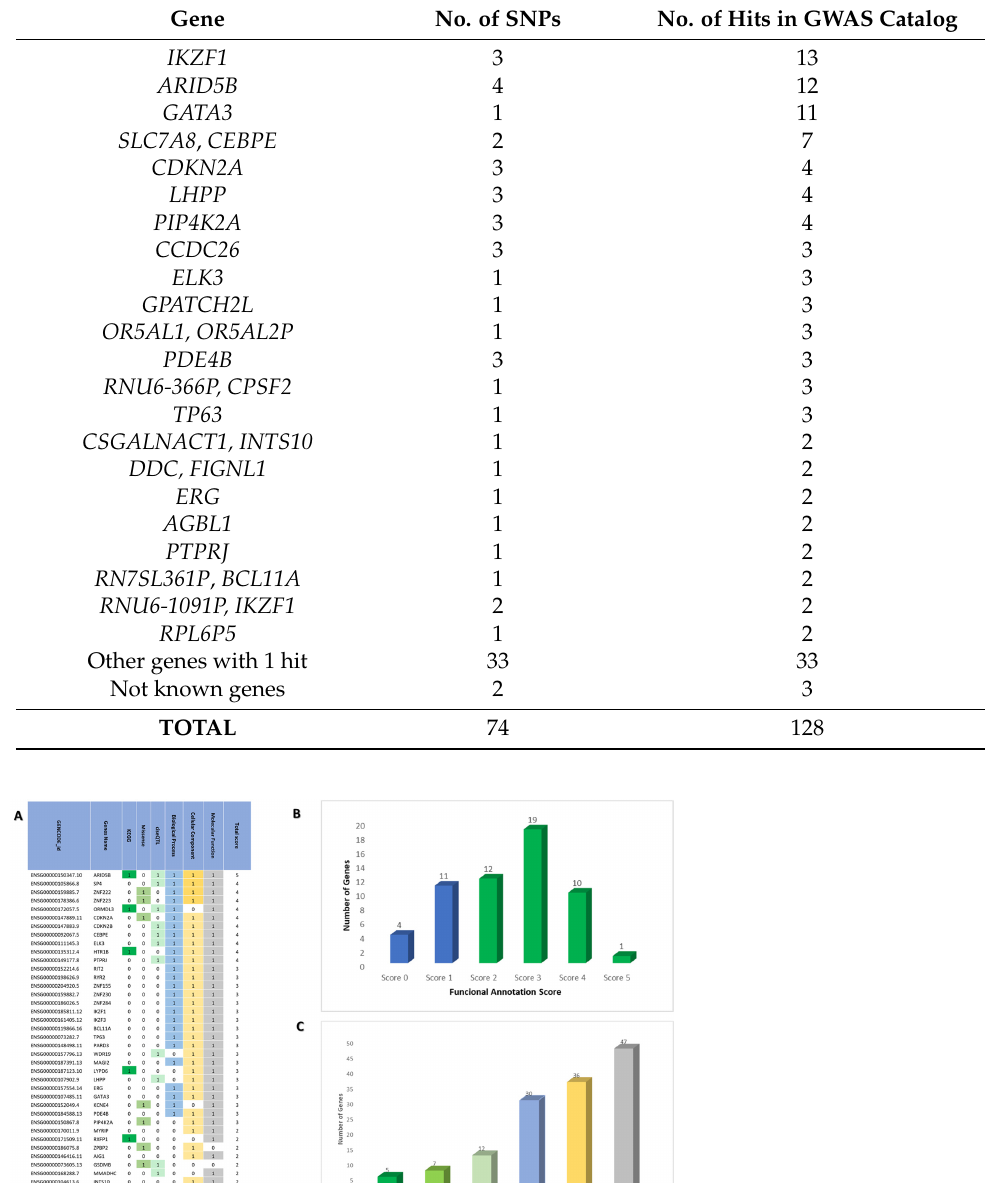
Table 1. ALL risk genes that were identified from the GWAS Catalog.